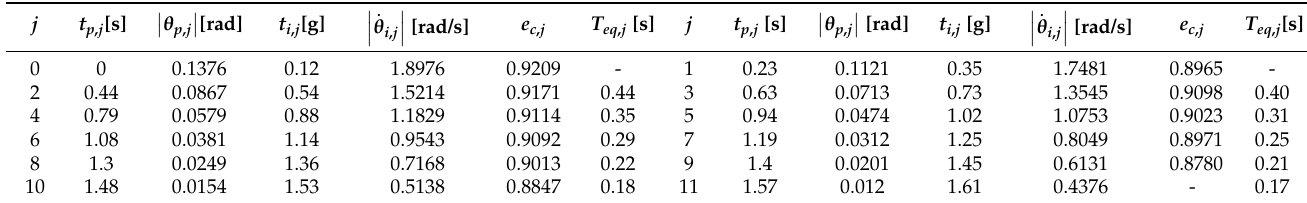
Table 9. Summary of the results of the free oscillation test block type C1.